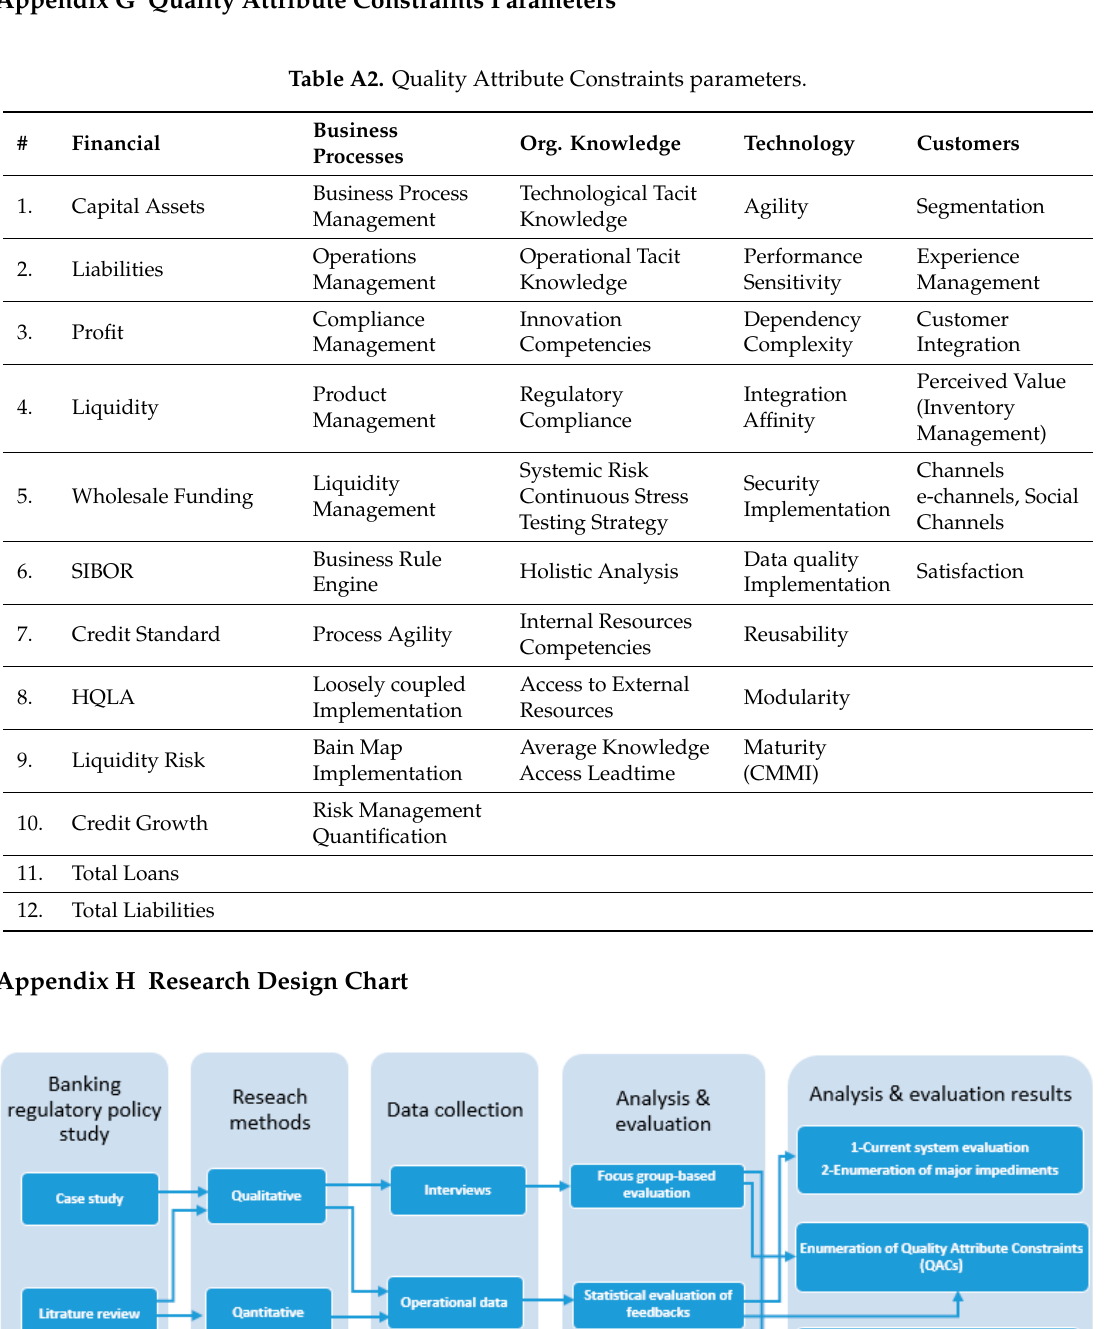
Table A2. Quality Attribute Constraints parameters.